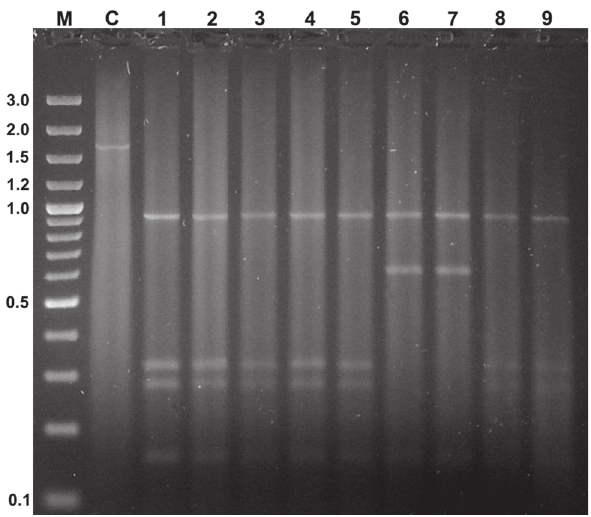
Figure 6. Hinf I RFLP patterns of a fragment of the gene COI in